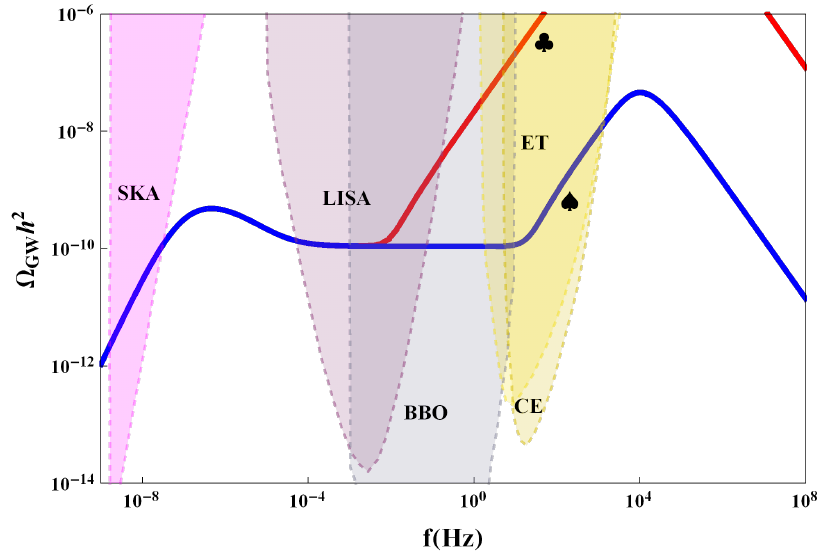
Figure 3 . EOS: ω = 1 . The curve in blue (red) is a valid (invalid) signal of leptogenesis. The curves are generated with Gµ = 10 − 12 and T ∗ = 10 − 1 GeV (red) and T ∗ = 10 2 GeV (blue). A fall at a high frequency is due to the particle production from cusps for l < l cric = µ − 1 / 2 have shown the spectrum only for the fundamental